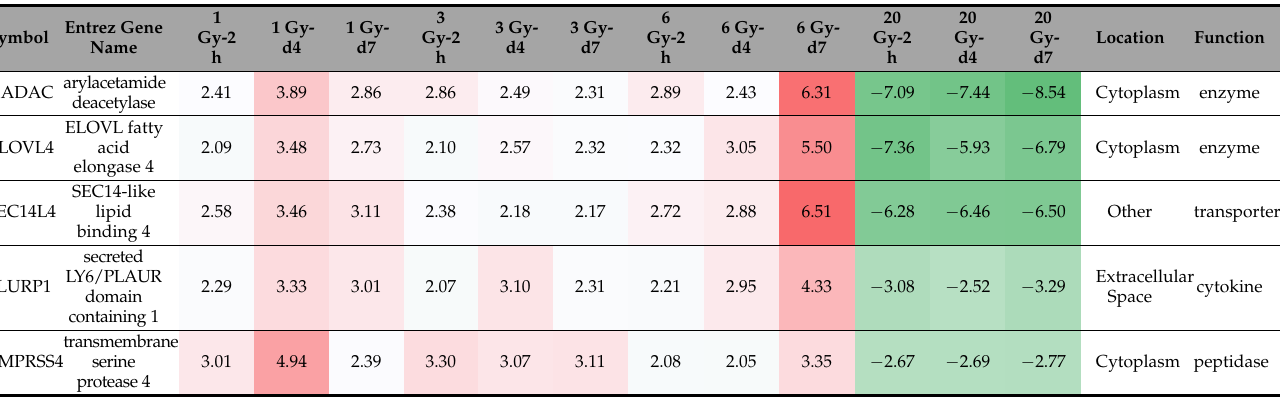
Table 7. Commonly modulated genes in all time points after exposure to lethal and sublethal IR doses. Note the opposite response in gene regulation to sublethal and lethal